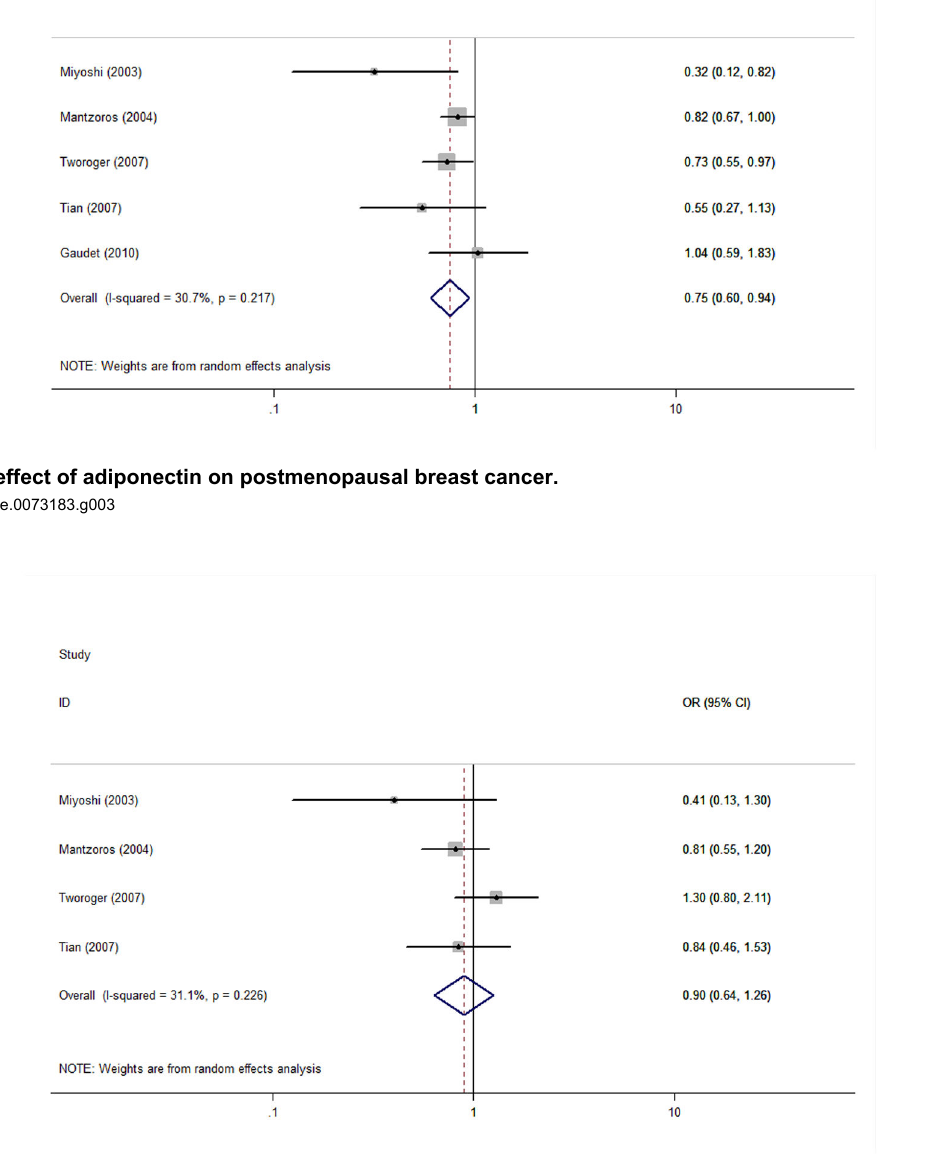
Figure 4. The effect of adiponectin on premenopausal breast cancer. doi: